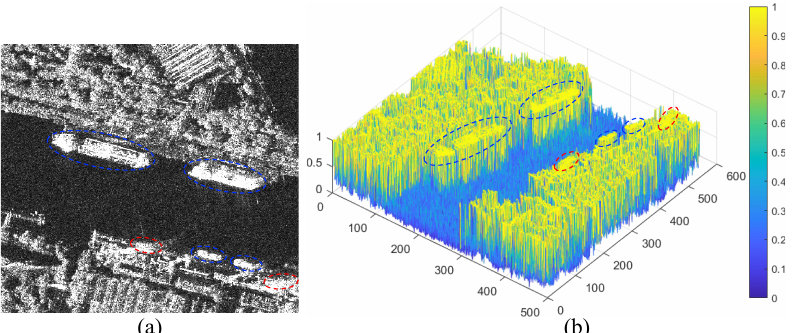
Figure 1. A difficult case of inshore ship detection in an SAR image. ( a ) SAR image acquired by TreeaSAR-X with 3 m resolution. ( b ) The mesh map of the SAR image intensity. The inshore ships and harbor facilities are marked in blue and red dotted circles, respectively. This indicates that inshore ships are difficult to separate from onshore pixels through scattering intensity